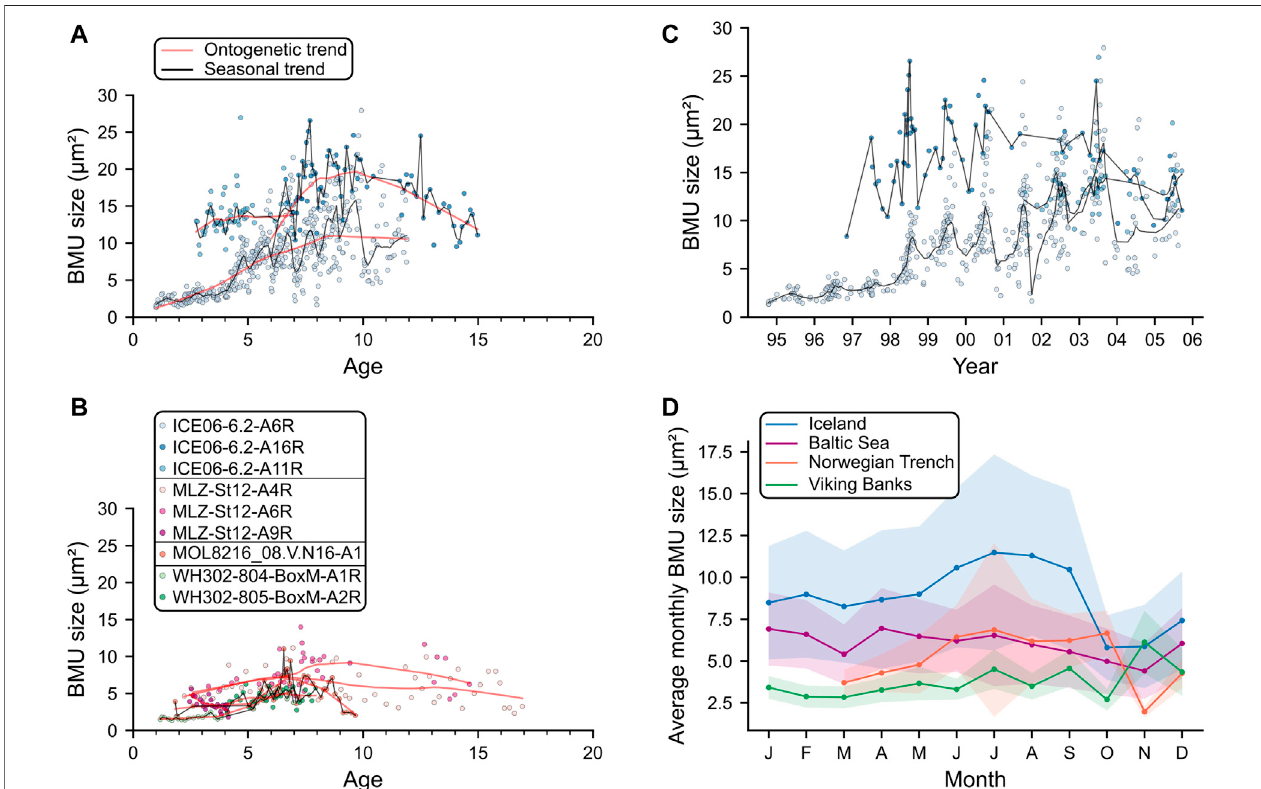
FIGURE 5 | Temporal BMU size trends of the hinge plates of Arctica islandica . Ontogenetic BMU size curves for studied specimens from Iceland (A) and the remaining localities (B) . At all localities, BMU size exhibited a parabolic trend over the lifetime of the animal (red lines), attaining maximum values at age seven to nine. In addition to this ontogenetic trend, all shells except those from the Baltic Sea exhibited seasonal variation of BMU size (black lines). (C) BMU data of the Icelandic specimens against calendar time. (D) Average monthly BMU sizes of each locality. Trend lines were calculated by locally weighted scatter plot smoothing (Cleveland, 1979) using a window size of one-third of the data for the long-term curves and 2 years of data for the seasonal curves.